Question: Give a one-sentence summary of this figure.
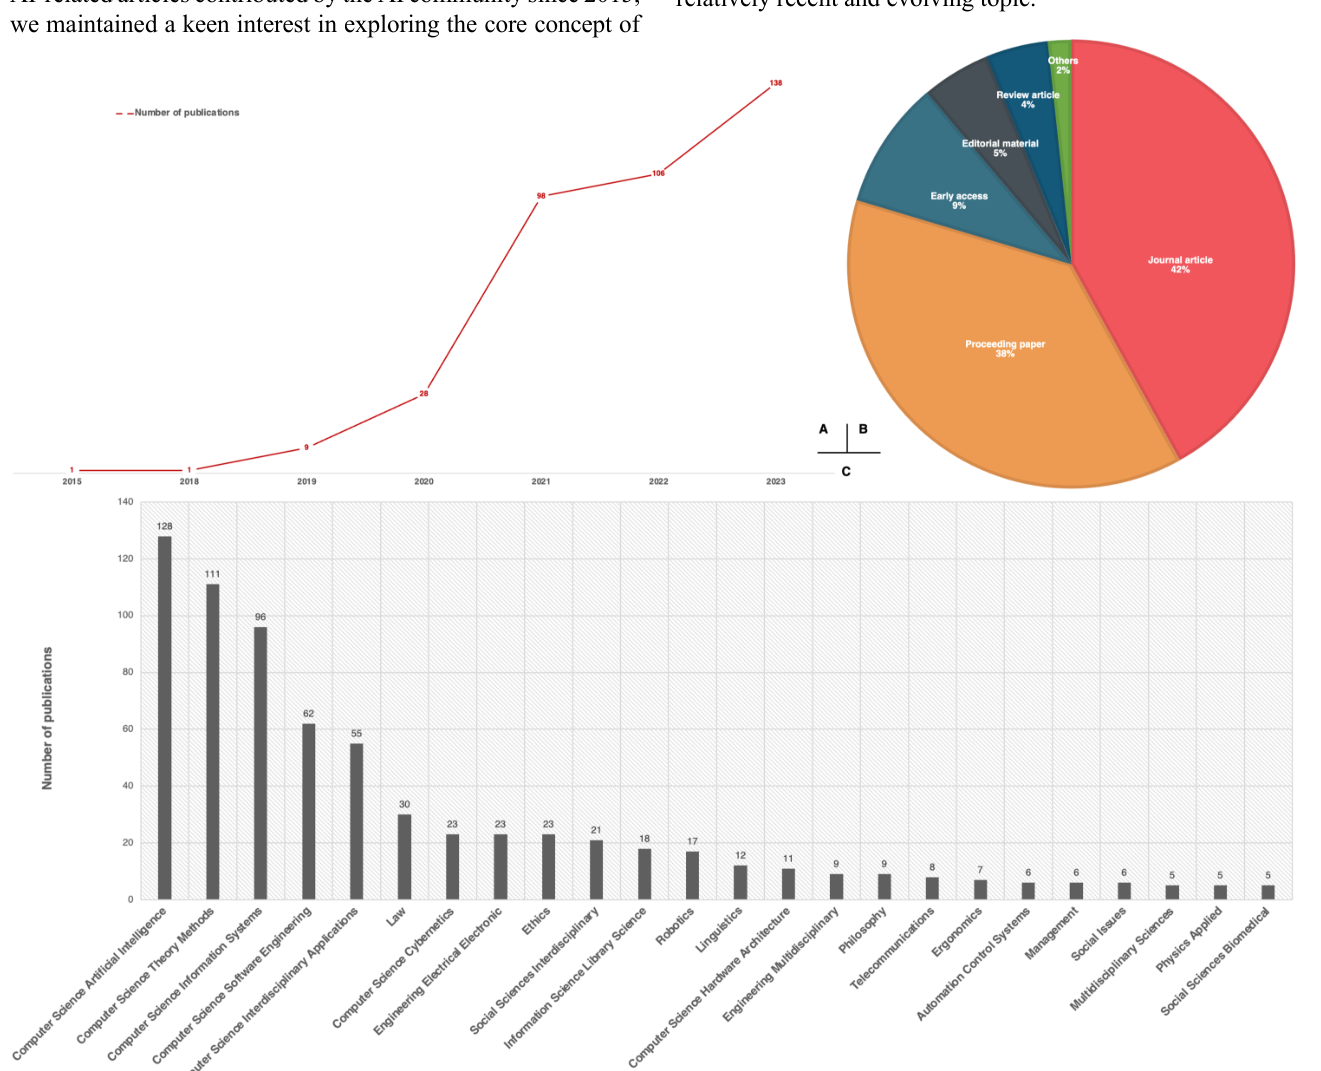
Answer: Portraits of the Core Cohort of Responsible AI Research: A) Publication Trend, B) Distribution of Article Types; and C) Distribution of the WoS Subject  Categories (with at least 5 articles).  Notes. 1) An article may have more than one article type, and thus, Fig. 8B exhibit overlaps. 2) While the core cohort spans across 89 WoS subject categories, the  24 subject categories depicted in Fig 7C encapsulate 334 articles – 87.9% of the core cohort.